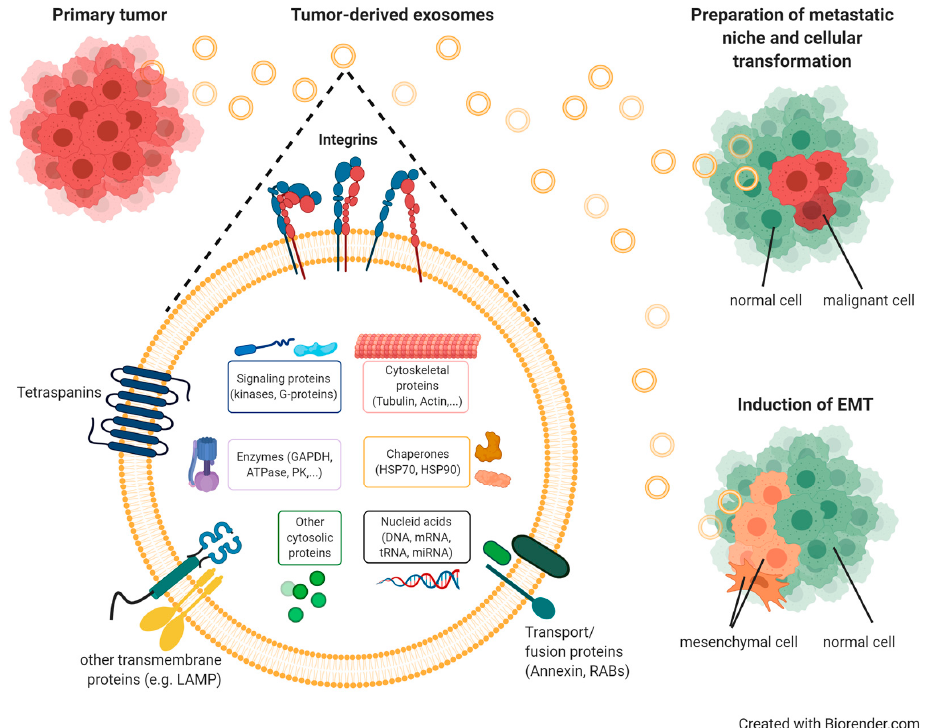
Figure 5. Tumor exosome-mediated intercellular communication and the formation of a pre-metastatic niche. For the final colonization of circulating tumor cells, an appropriate niche at the metastatic site has to be created as well as EMT induced. The formation of such a pre-metastatic niche requires the communication of tumor cells with the local environment of a distant organ by the release of tumor-derived exosomes that deliver their pro-tumorigenic cargo to specifically targeted organs. Depicted is a scheme of a typical exosome that encloses some of the common exosomal components. In addition, integrins are expressed on the exosomal surface, which are capable of anchoring to distinct ECM proteins at the metastatic site.